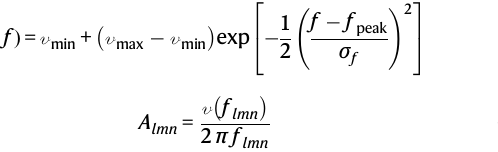
for v max =50cm/s,zero v min , f peak =1210 μ Hz,and σ f =300 μ Hz.Theletters f andthe numbersindicate,respectively,f-modesandtheradialorderofp-modes,upto n